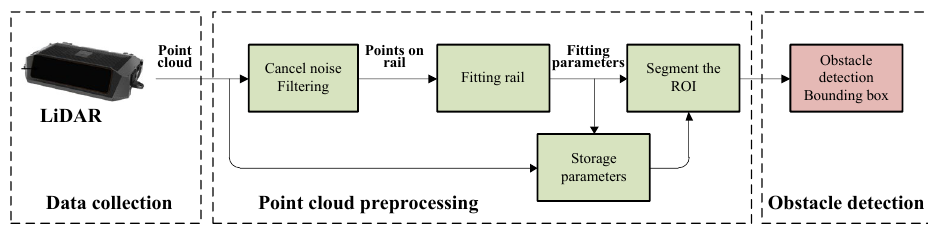
Figure 1. The obstacle detection system’s construction.